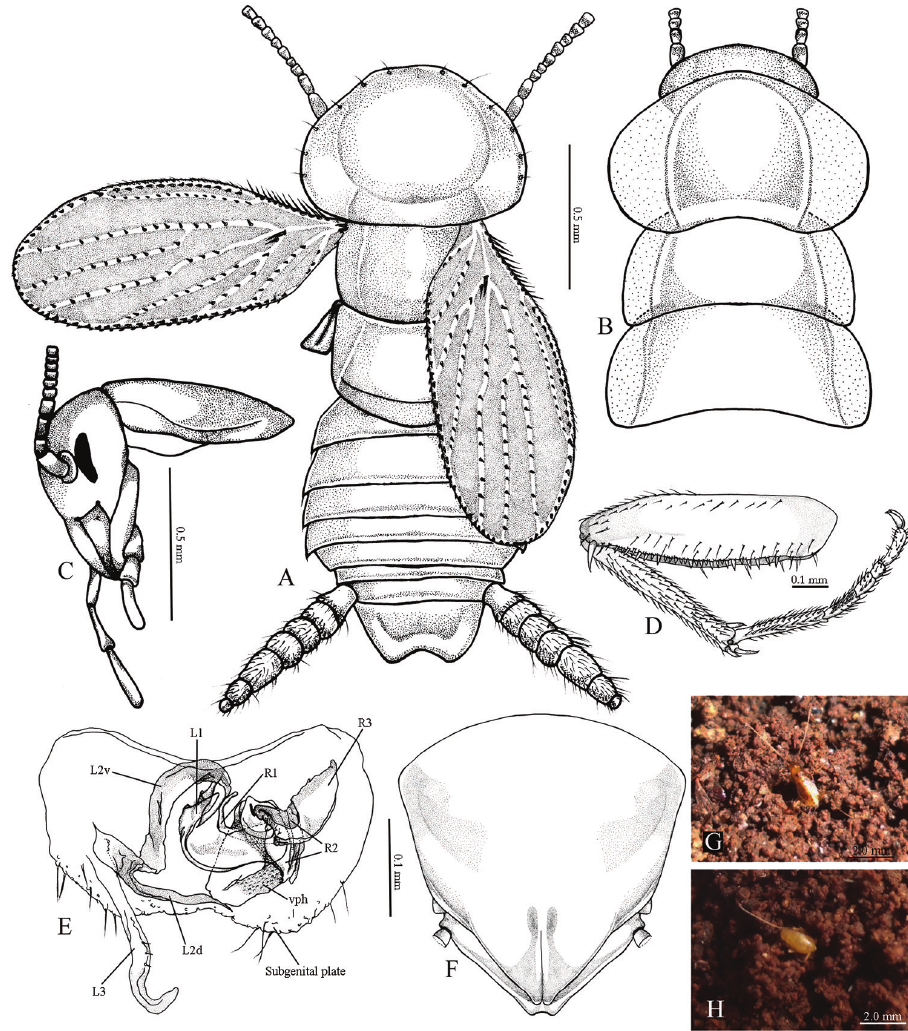
Figure 1. Nocticola gonzalezi Lucañas & Lit, sp. n.: A Adult male B adult female C male head, lateral aspect D Prothoracic leg E male genitalia: (L1-3: sclerites of left phallomere; L2d: L2 dorsal; L2v: L2 ventral; R1-3: sclerites of right phallomere; vph: ventral phallomere) F female subgenital plate G male and H female